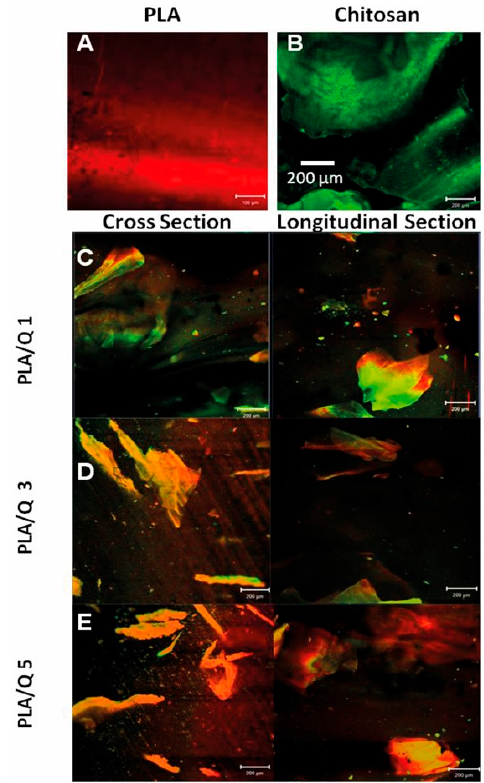
Figure 1. Confocal microscopy micrographs of ( A ) Polylactic acid (PLA), ( B ) Chitosan particles, and ( C – E ) PLA/chitosan composites. The PLA and chitosan particles show red ( A ) and green ( B ) autofluorescence,